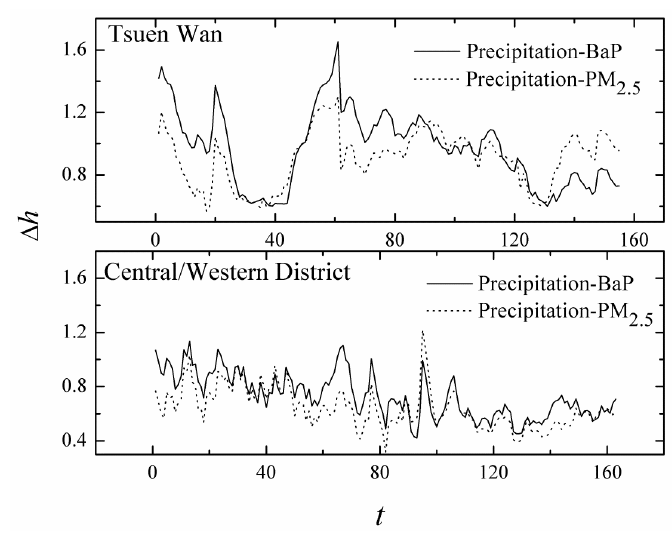
Figure 4. The temporal distribution of ∆ h between BaP–precipitation and PM 2.5 –precipitation for the two sites, based on the sliding window technique.